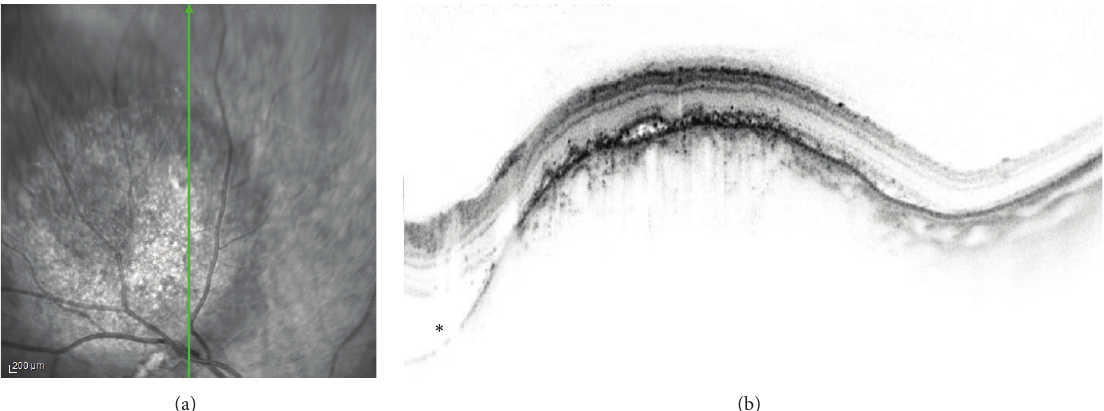
Figure 3: Right eye choroidal metastasis in a patient with parotid carcinoma. The amelanotic tumor is demonstrated superotemporal to the optic disc in the infrared image (a). Vertical OCT scan (b) at the center of the tumor showing an irregular anterior choroidal surface, structural loss of the inner segment ellipsoid band, and a small quantity of subretinal fluid with hyperreflective speckles. Note also the subretinal fluid adjacent to the tumor (asterisk).